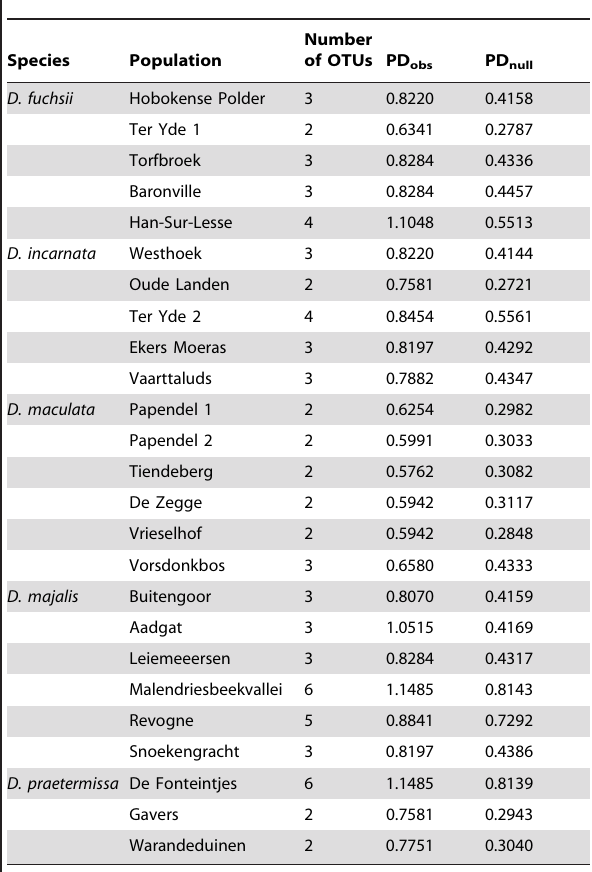
Table 2. The number of operational taxonomic units and phylogenetic diversity (PD) values for each sampled population of five Dactylorhiza